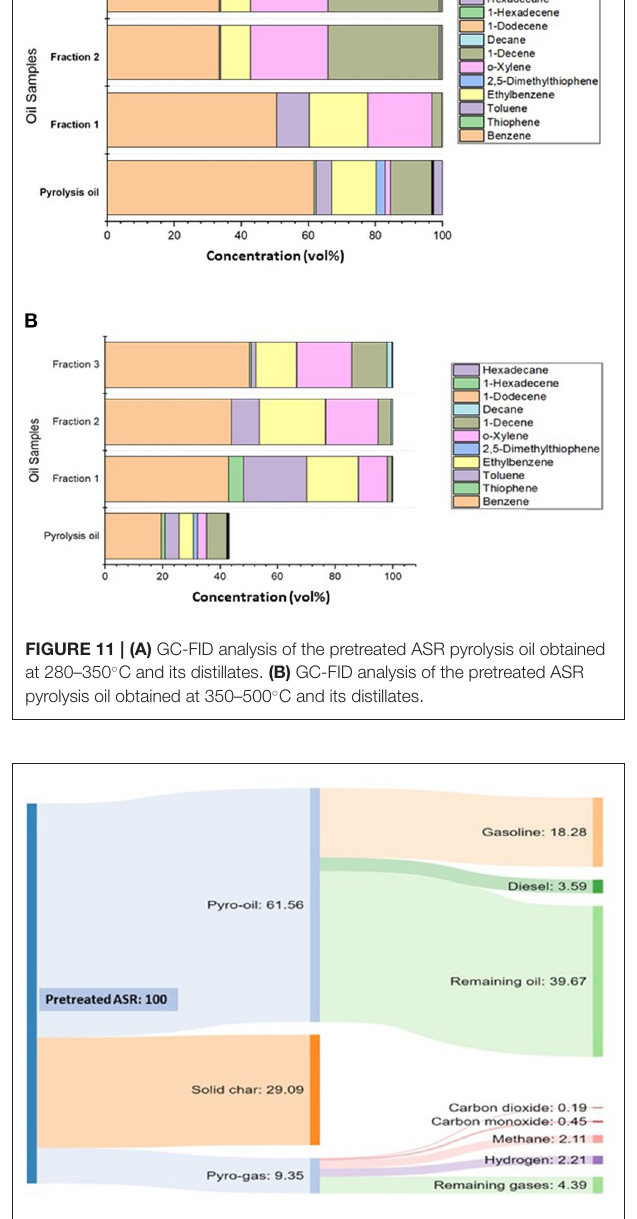
FIGURE 12 | Representation of mass balance of pretreated ASR pyrolysis process at 350–500 ◦ C by Sankey